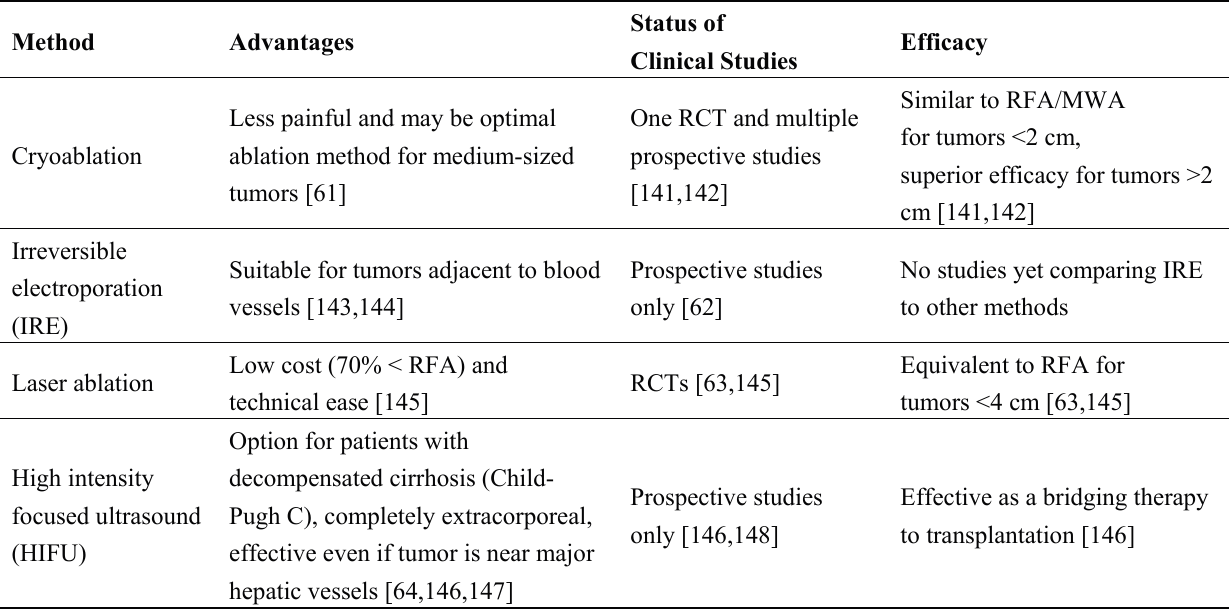
Table 2. Emerging ablation